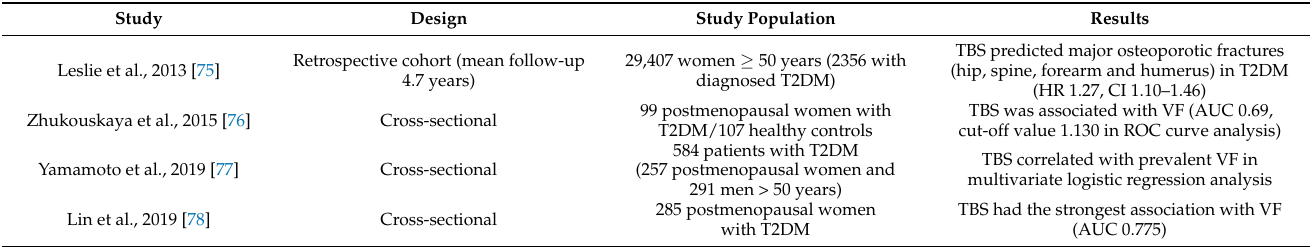
Table 1. Clinical studies showing an independent association between the trabecular bone score (TBS) and osteoporotic fractures in patients with type 2 diabetes